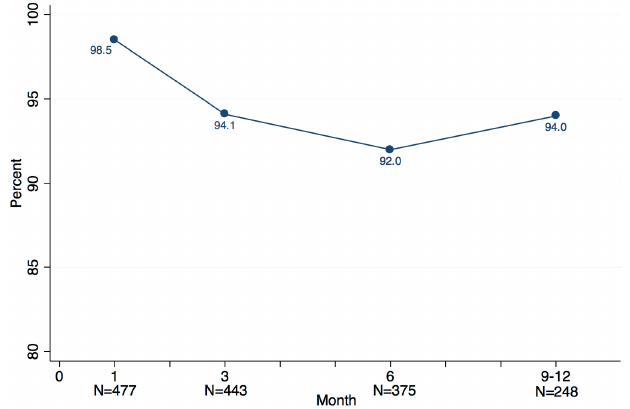
Figure 1. Compliance with Vitamin B6 supplementation.